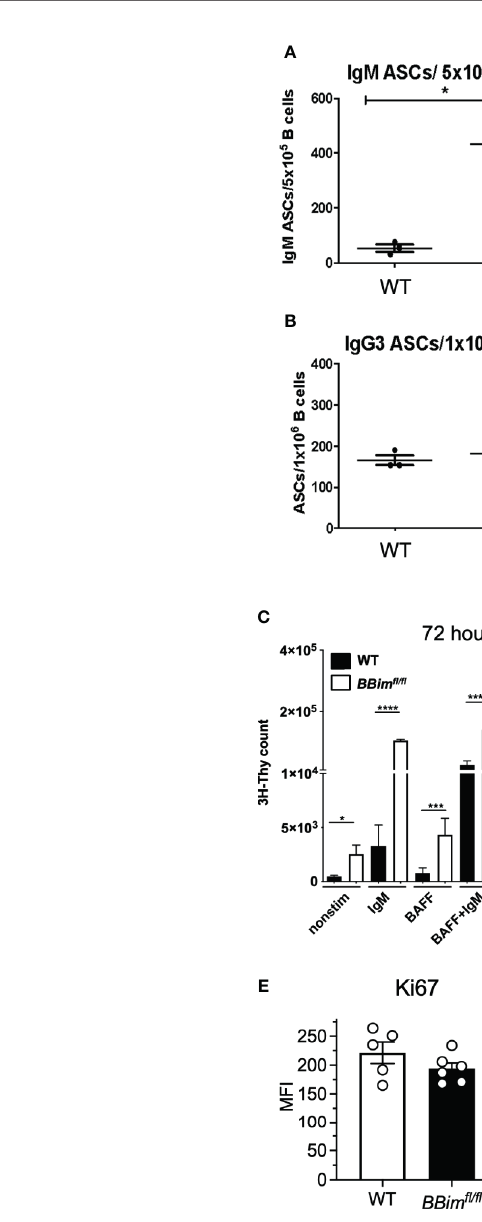
FIGURE 8 | BCR and TLR induced BBim fl / fl B cell proliferation is enhanced by BAFF. B cells from WT and BBim fl / fl mice were analyzed for differences in activation and proliferation. WT and BBim fl / fl mice were immunized with TNP-Ficoll, before measuring B cell and antibody response by ELISpot. Quanti fi cation of (A) IgM and (B) IgG3 antibody secreting B cells from BBim fl / fl and WT mice. (C) 3 H-Thymidine incorporation assay after treatment with indicated agonist for72 hours. (D) 3 H- Thymidine incorporation of B cells treated with the indicated agonist for 48 hours. (E) MFI of Ki67 in B cells from BBim fl / fl and WT mice. (F) Circulating BAFF levels in serum from BBim fl / fl and WT mice. *P ≤ 0.05, **P ≤ 0.01, ****P ≤ 0.0001, calculated by Students